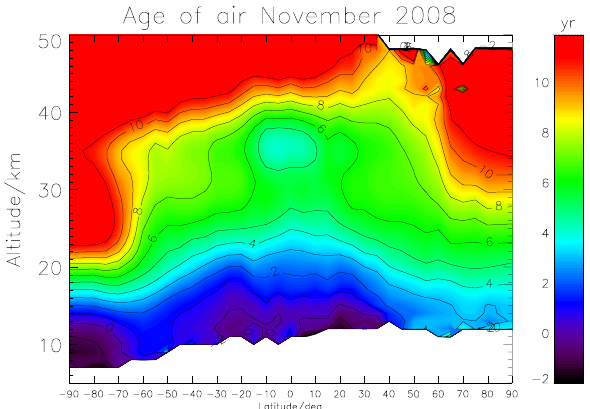
Fig. 7. Zonal mean distribution of mean age of air of Novem- ber 2008 showing the beginning break-down of the polar vortex and the intrusion of relatively young air to polar latitudes around 35km.